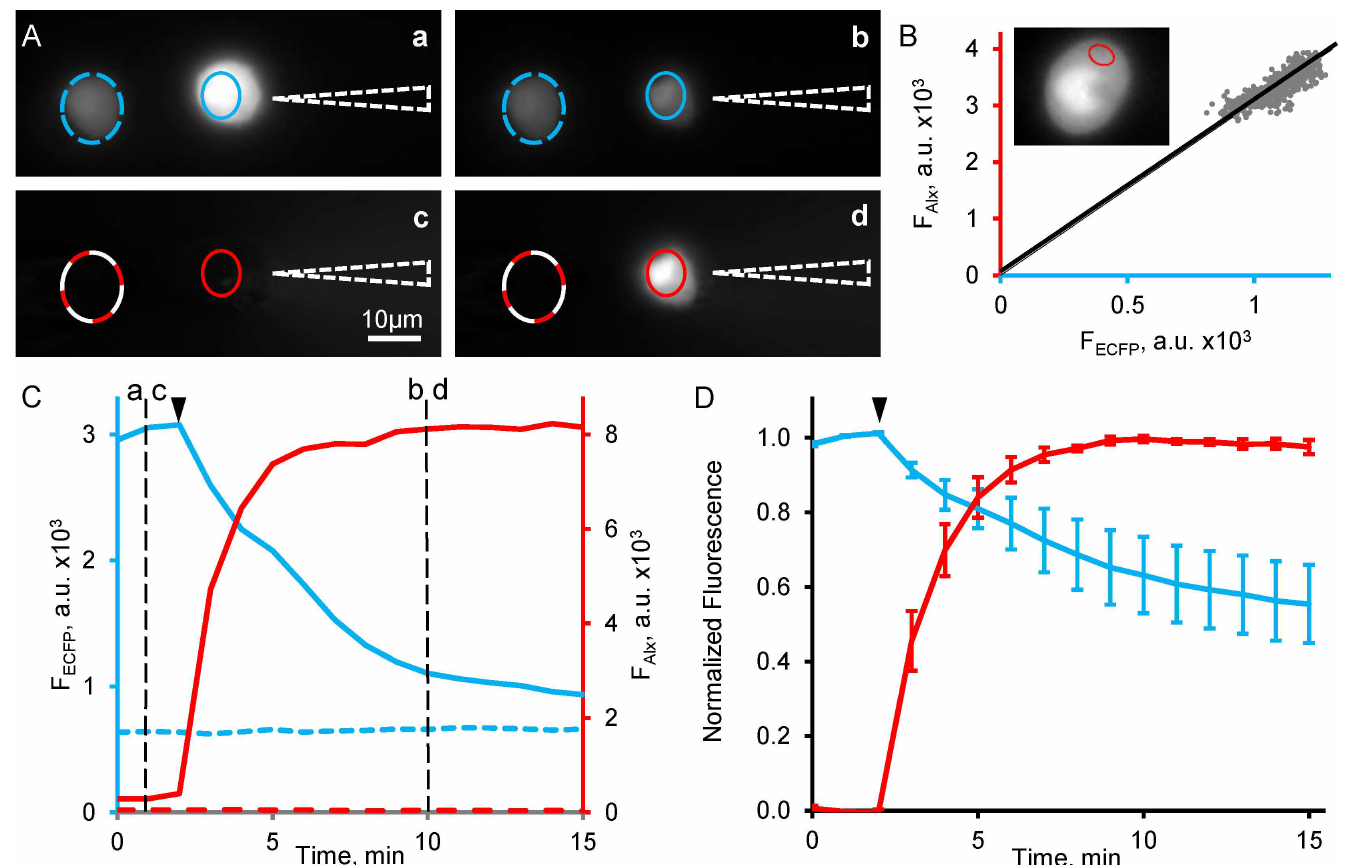
Fig 3. Estimation of ECFP concentration in PC12 cells. ECFP expressing PC12 cells were filled with Alexa Fluor 594 via patch pipette. (A) Images of two PC12 cells obtained in ECFP (a, b) and Alexa Fluor 594 (c,d) channels right before the cell membrane rupture (a, c) and in 10 min after the rupture (b, d). Images were taken at the moments indicated by black dashed lines in (C). A position of patch pipette are depicted in (A) by white dotted triangles. Scale bar is 20 μ m. (B) A correlation plot of ECFP and Alexa Fluor 594 fluorescence intensities for a cytoplasmic part of cell. Each dot in the correlation plot represents a pixel located in a red oval depicted within the cytoplasmic part of cell, of which an image is shown in the insert (ECFP channel). ECFP and Alexa Fluor 594 images used for building the correlation plot were obtained by averaging all frames in ECFP channel taken before the cell rupture and all frames in Alexa Fluor 594 channel between 10 and 15 min. A linear regression without offsets for this plot indicates to reasonable correlation between the fluorescent values (R 2 = 0.67). (C) Time courses of cell loading with Alexa Fluor 594 (red traces) and washing out of ECFP (blue traces). Fluorescence intensities for both labels were calculated in ROIs shown in (A) as an average intensity of all pixels within each ROI. Solid and dashed lines in ROIs (A) and time courses (C) correspond to the patched and intact cell, correspondingly. Cell rupture is indicated by black arrowheads in (C) and (D). Alexa Fluor 594 fluorescence ( F ) reached a plateau in about 5 min after the membrane rupture indicating an equilibrium state at which Alx the concentration of Alexa Fluor 594 inside the cell and in the patch pipette are expected to be equal. Residual fluorescence in ECFP channel indicates that some ECFP molecules (about 30%) are retained in intracellular compartments. Images were taken at the rate of 1 min per frame for each channel in order to minimize photo- bleaching. ECFP photobleaching in a control cell at this frame rate was negligible (dashed blue trace in Fig 3B); thus, it could be also neglected in the patched cells. (D) Time courses from five cells were normalized and averaged, representing a perfusion dynamics of Alexa Fluor 594 (red traces) and washing out of ECFP (blue traces), analogous to those in